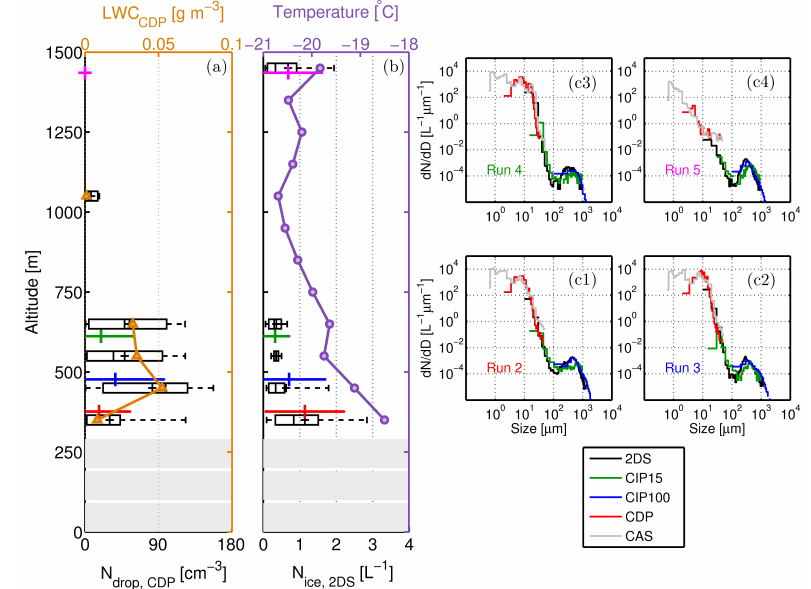
Figure 6. Microphysics summary of averaged observations over the sea ice. (a) CDP droplet number concentration (boxes, black) with derived liquid water content overlaid (orange). (b) 2DS ice crystal number concentration (boxes, black) with mean temperature measured overlaid (purple). Only CDP and 2DS data > 0.5cm − 3 and > 0.05L − 1 respectively have been included. Box edges represent the 25th and 75th percentiles, and the median and mean values are denoted by | and + respectively. Altitudes not sampled are blocked out ( ≤ 300m). (a, b) Number concentrations from each SLR are shown in colour at each corresponding altitude (run 2: red, run 3: blue, run 4: green, run 5: magenta). Arithmetic means are indicated ( | ) with each horizontal bar extending to ± 1 σ . (c1–4) Number size distributions (d N/ d D ) from each SLR over the sea ice (runs 2–5). Legend refers to (c) only. Table 2. Straight and level run information. Values quoted are arithmetic mean quantities, with 1 σ listed in